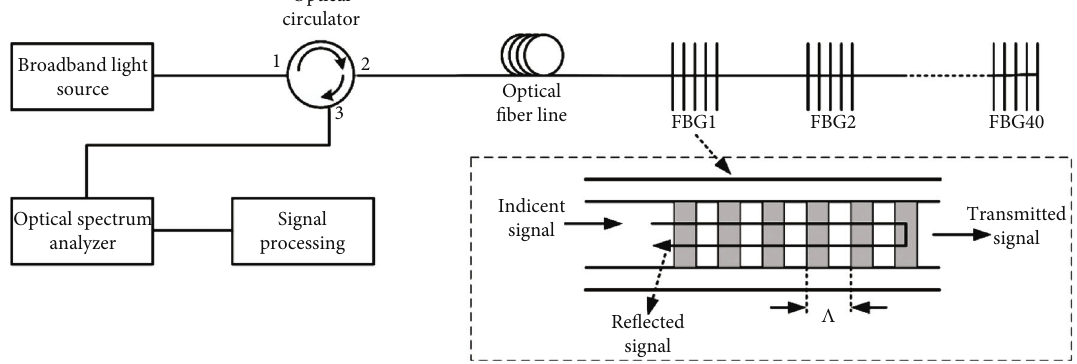
Figure 13: Simulation setup for testing FBG sensors ’ operation